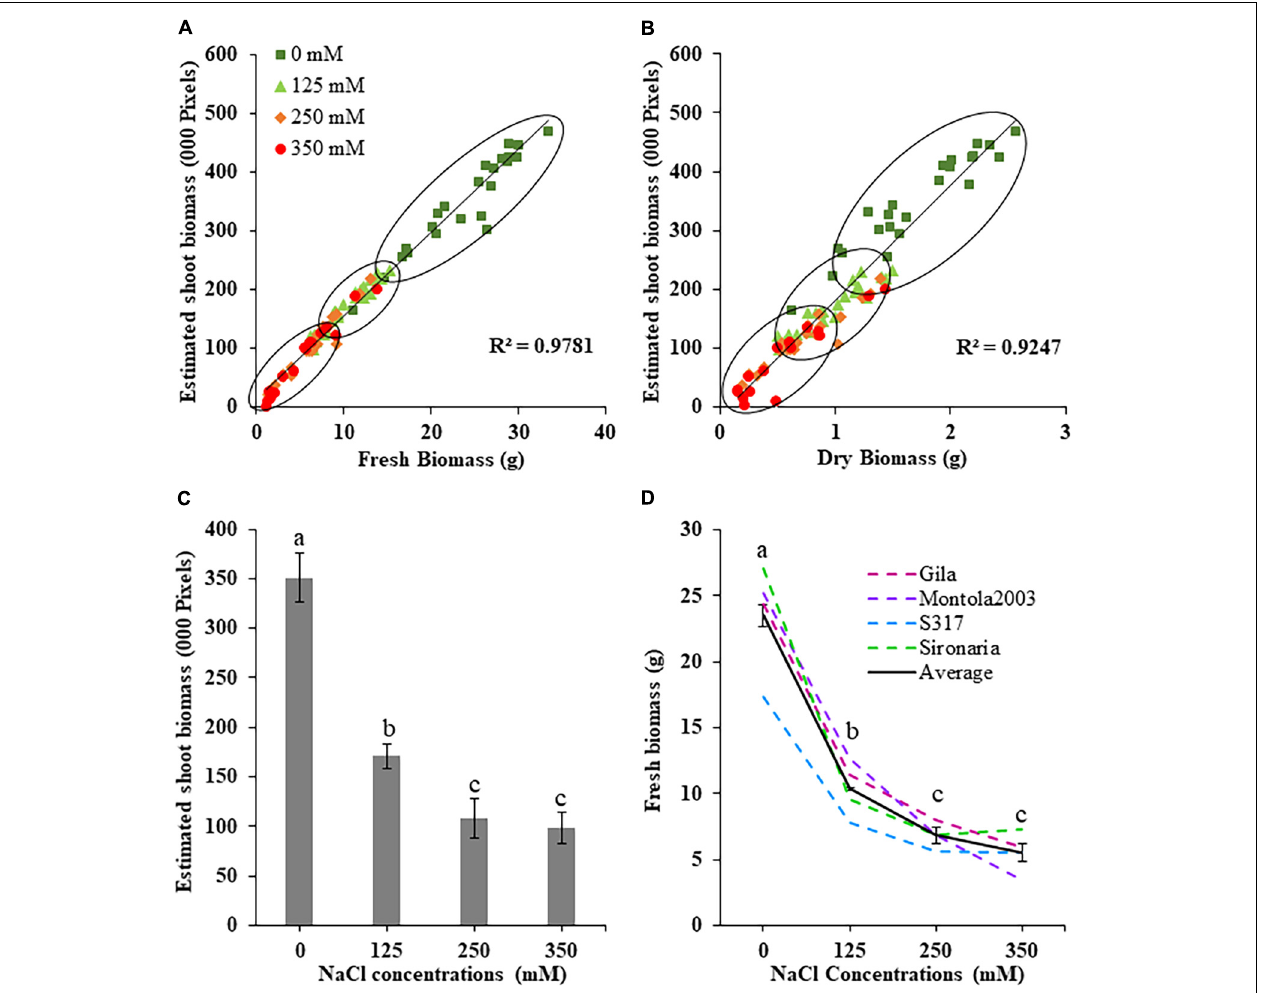
FIGURE 2 | Measured and estimated shoot biomass in safflower genotypes at four salt (NaCl) concentrations from first experiment. (A) Correlation between estimated shoot biomass and fresh biomass and (B) dry biomass harvested at 36 days after sowing. (C) Estimated shoot biomass accumulation for all genotypes at the four salt concentrations. (D) Fresh biomass at the four salt concentrations for the four safflower genotypes and average of all genotypes. Data represents mean and standard deviation. n = 96. Different letter (a,b,c) indicate a significant difference ( P < 0 . 05) for fresh biomass at different salt